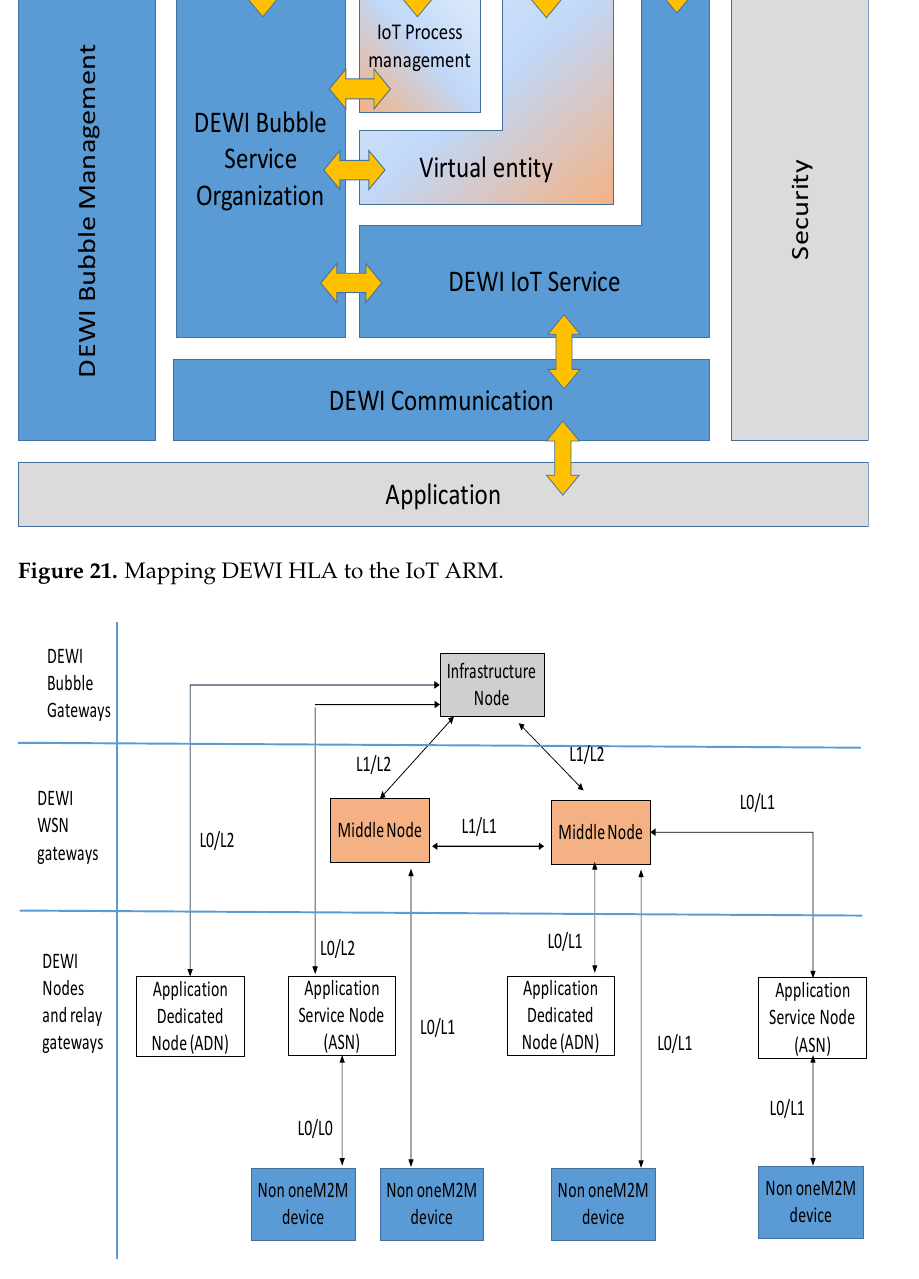
Figure 22. Mapping DEWI HLA to the oneM2M